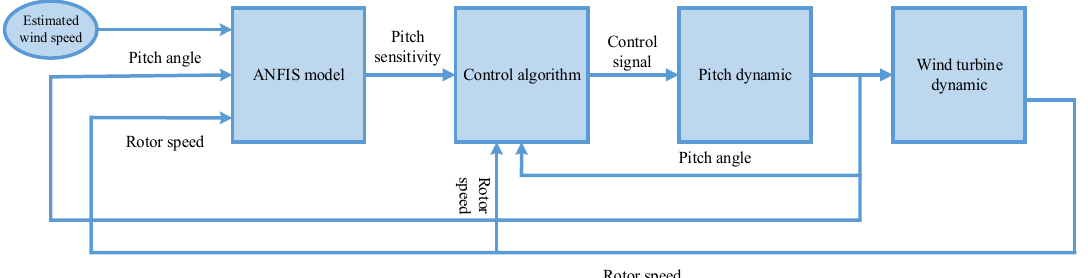
Figure 13. Schematic of the designed control system in region III. The control parameters can be found in Appendix C.